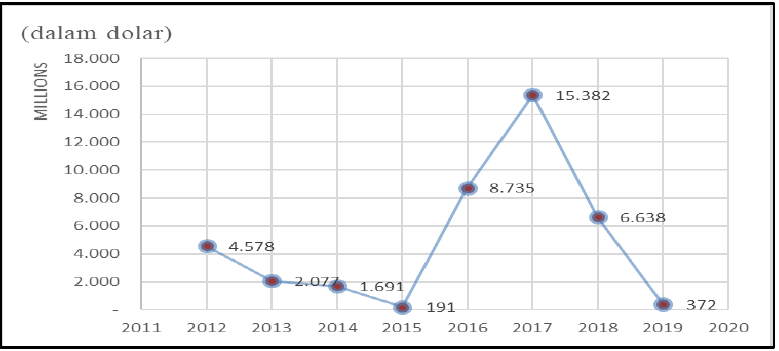
Figure 1. Investment value of PPP infrastructure projects in